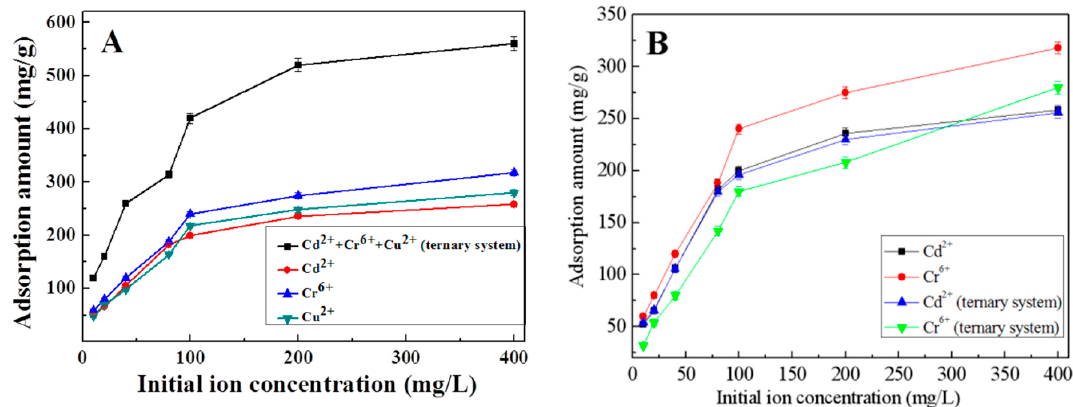
Figure 10. Adsorption capacity of K-Ac examined in heavy metal ion Cu 2+ , Cr 6+ , and Cd 2+ solution; ( A ) total adsorption amount of elements in ternary systems and single adsorption capacity of each ion in single system; ( B ) single-element adsorption amount of Cd 2+ and Cr 6+ in different